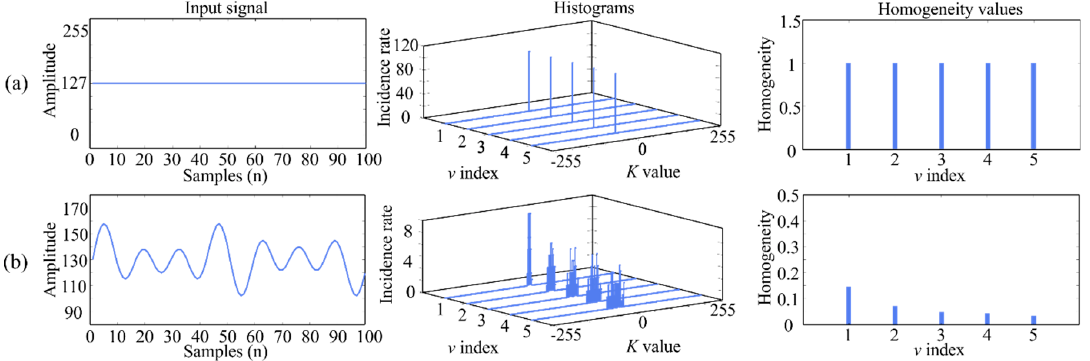
Figure 2. Homogeneity: ( a ) time-constant signal and ( b ) time-varying signal.